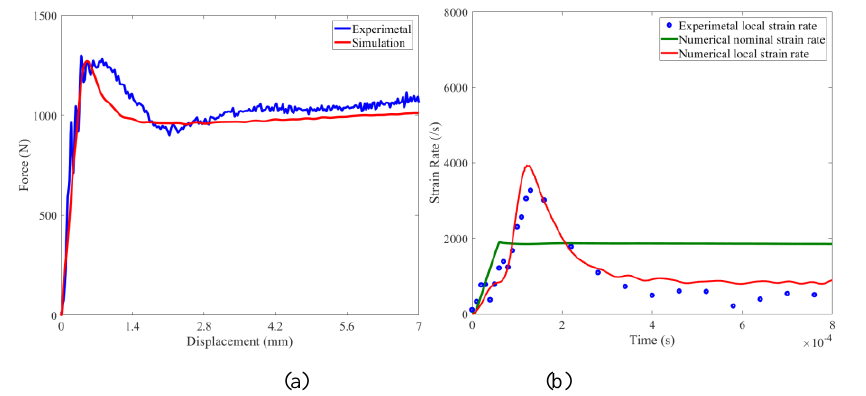
Fig.7 Comparison of (a) macro force-displacement and (b) local strain rate histories between the numerical results and experimental measurements for